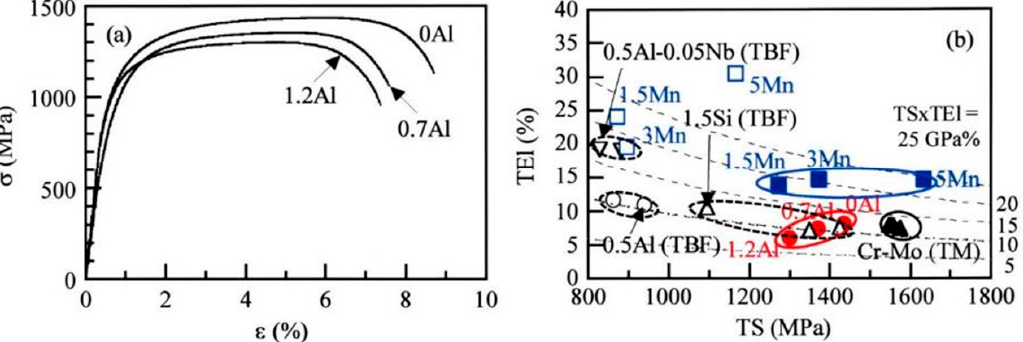
Figure 10. ( a ) Engineering stress–strain ( σ - ε ) curves of 0.20C-1.50Si-1.24Mn-0.20Cr-0.022Al-0.0028 (0Al), 0.20C-0.73Si-1.24Mn-0.19Cr-0.72Al-0.0027B (0.7Al), and 0.20C-0.20Si-1.24Mn-0.20Cr-1.22Al- 0.0026B (1.2Al) TM steels [55,88]. ( b ) Combination of the tensile strength (TS) and total elongation (TEl) of 0Al, 0.7Al, and 1.2Al TM steels ( ● ) [55,88], 0.2C-1.5Si-1.5Mn-(0-1.0)Cr-(0-0.2)Mo (Cr-Mo) TM steels ( ▲ ) [53], 0.2C-1.5Si-(1.5-5.0)Mn (1.5Mn, 3Mn, and 5Mn) M-MMn ( █ ) [59] and D-MMn ( □ ) [39,40] steels, 0.2C-1.5Mn-0.99Si-0.49Al (0.5Al) TBF steel